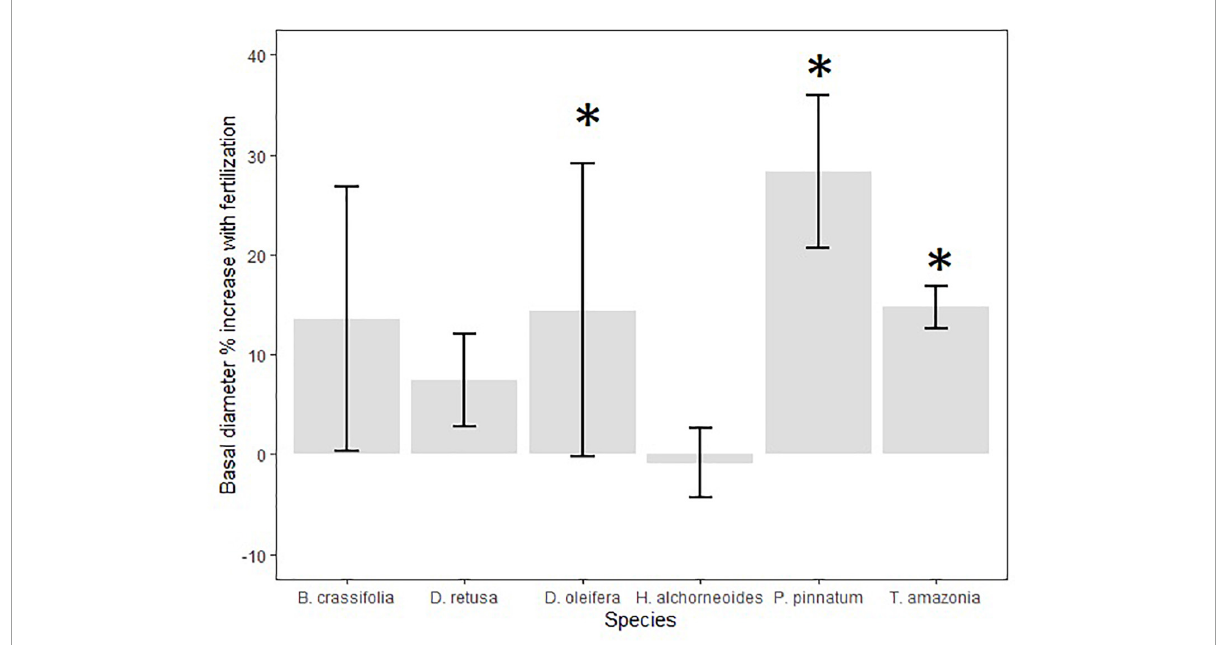
FIGURE5 Mean (SE) % increase in seedling growth (30-month basal diameter, cm) between fertilizer and control treatments (calculated as [((treatment/control)-1)*100]) among all planting areas. Fertilizer treatment seedlings received applications of chemical N-P-K fertilizer once annually; control seedlings were not fertilized after planting. Annual application of chemical fertilizer significantly increased basal diameter for D. retusa, T. amazonia, and P. pinnatum (indicated with ∗ ) but not the other three